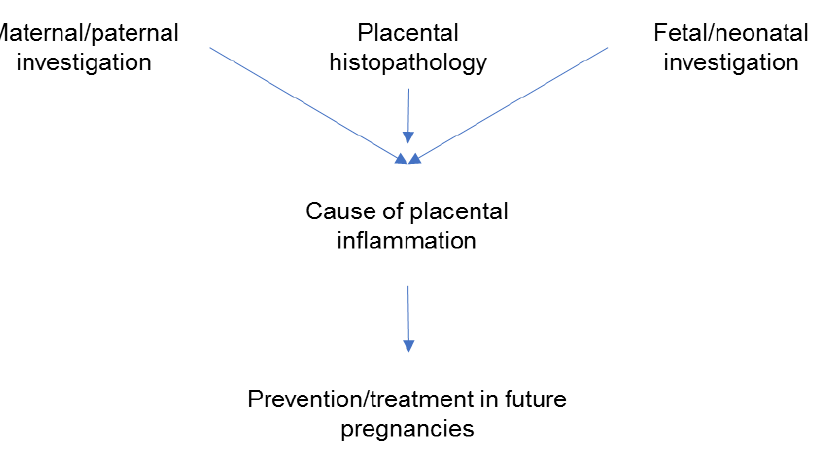
Figure 1. Steps in the clinical management of adverse pregnancy outcomes associated with placental inflammation; the focus is on prevention in subsequent pregnancies.